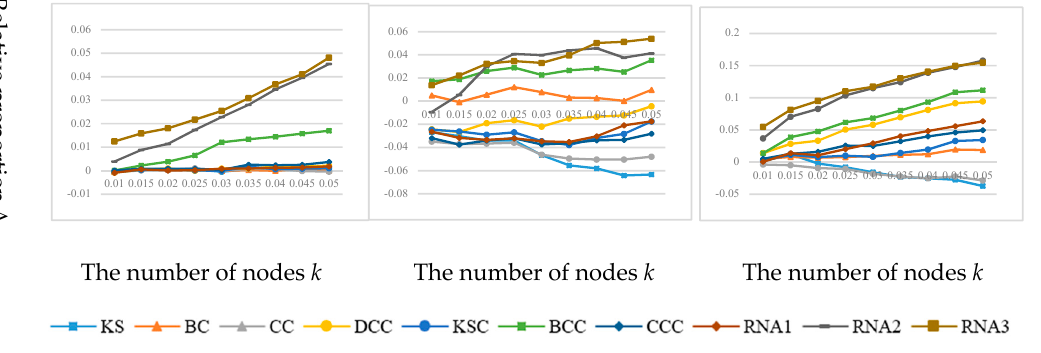
Figure 9. In the full-contact SIR model, the relationship between Δ and k with 𝛽 = 0.2 .